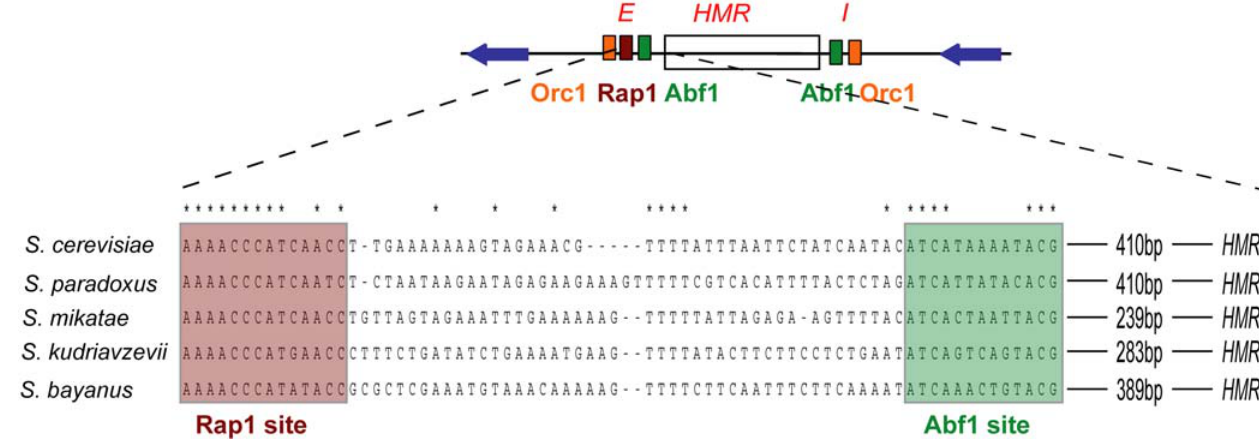
Figure 3. Conservation of the HMR-E silencer in five sensustricto species. Multiple alignment of the putative HMR-E silencer in the five sensu stricto species. There was strong conservation among all of the species of the Rap1 and Abf1 binding sites (shaded) and the spacing between them, with diverged intervening sequence from the Rap1 site to the Abf1 site. Similarly, even though the distance from the Abf1 site to HMR was identical in S. cerevisiae and S. paradoxus , DNA-level pairwise alignment of the region gave only 55% identity (Figure